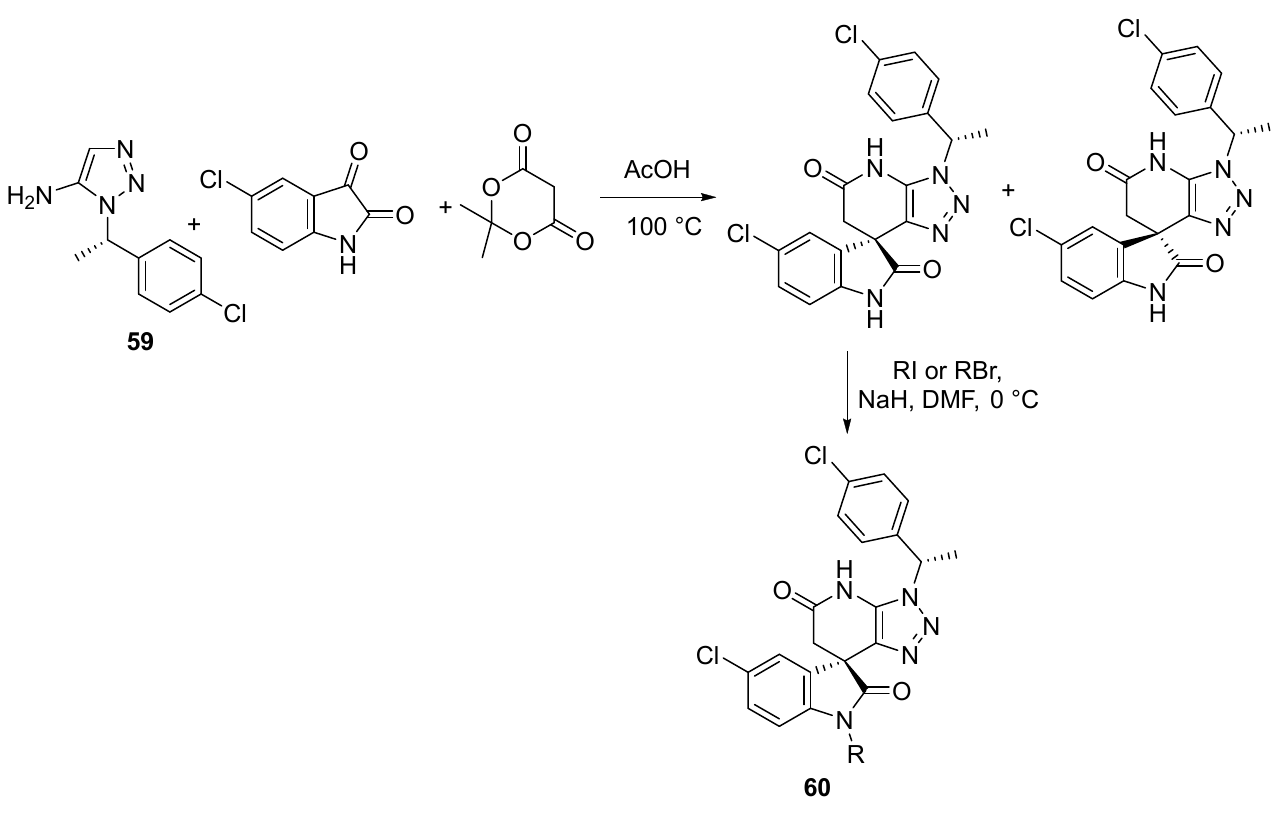
Scheme 14. Synthesis of spiro[[ 1,2,3]triazolo[4,5- b ]pyridine-7,3’-indolines] 60